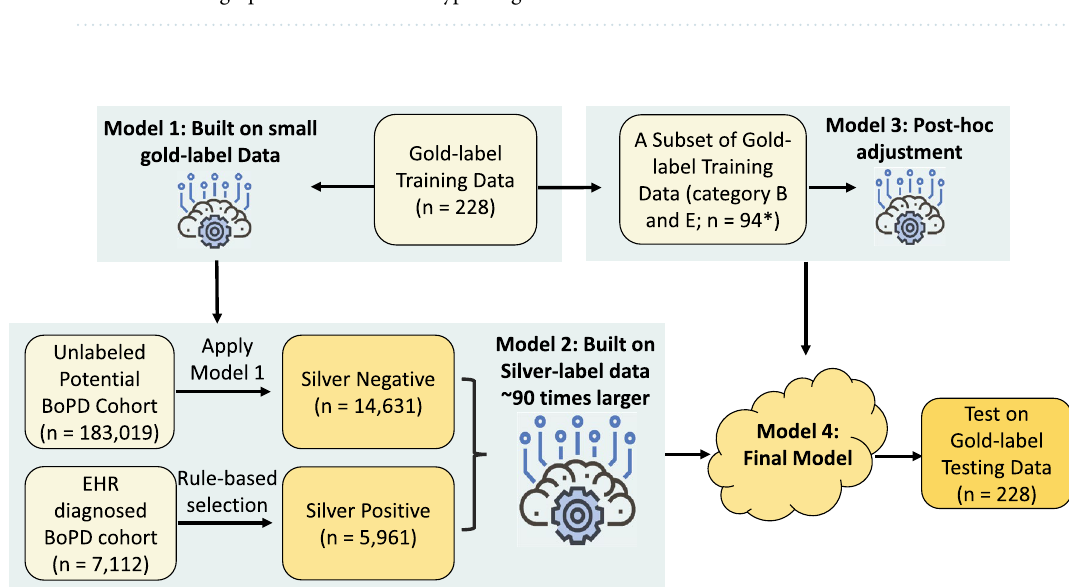
Table 1. Demographics and encounter types in gold-label and silver-label data sets.